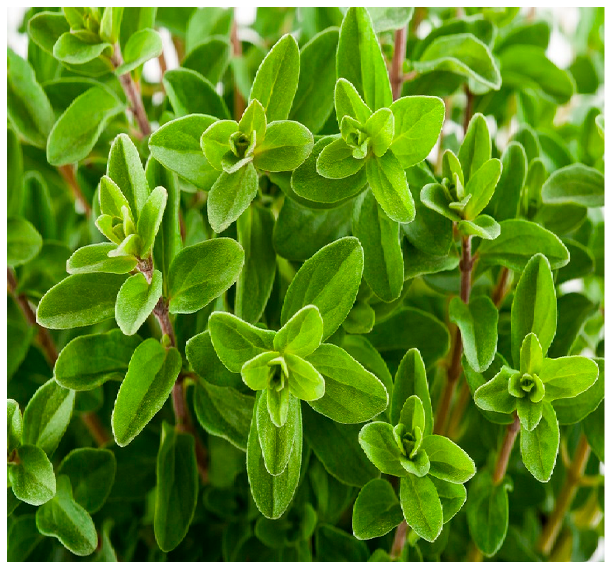
Figure 6. Image of Marjoram plant. Source: [106].